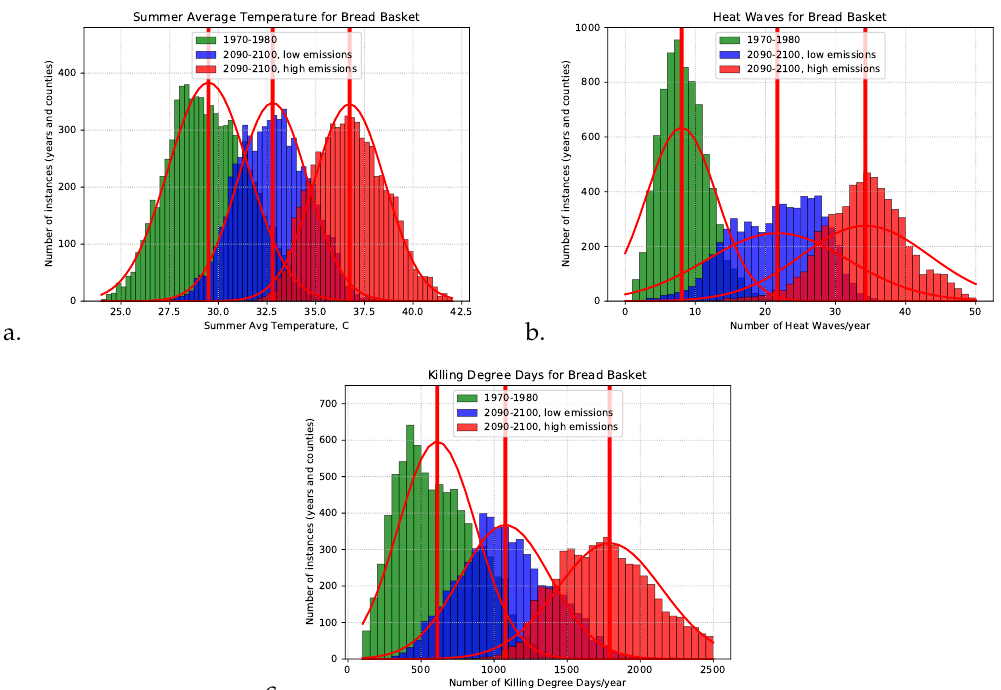
Figure 2. Distributions of summer average temperature ( a ), heat waves ( b ), and killing degree days ( c ) for historical (green), future low-emissions RCP 4.5 scenario (blue) and future high-emissions RCP 8.5 scenario (red). Results are for the US corn growing region. Historical data from [35] and future projections from [41].